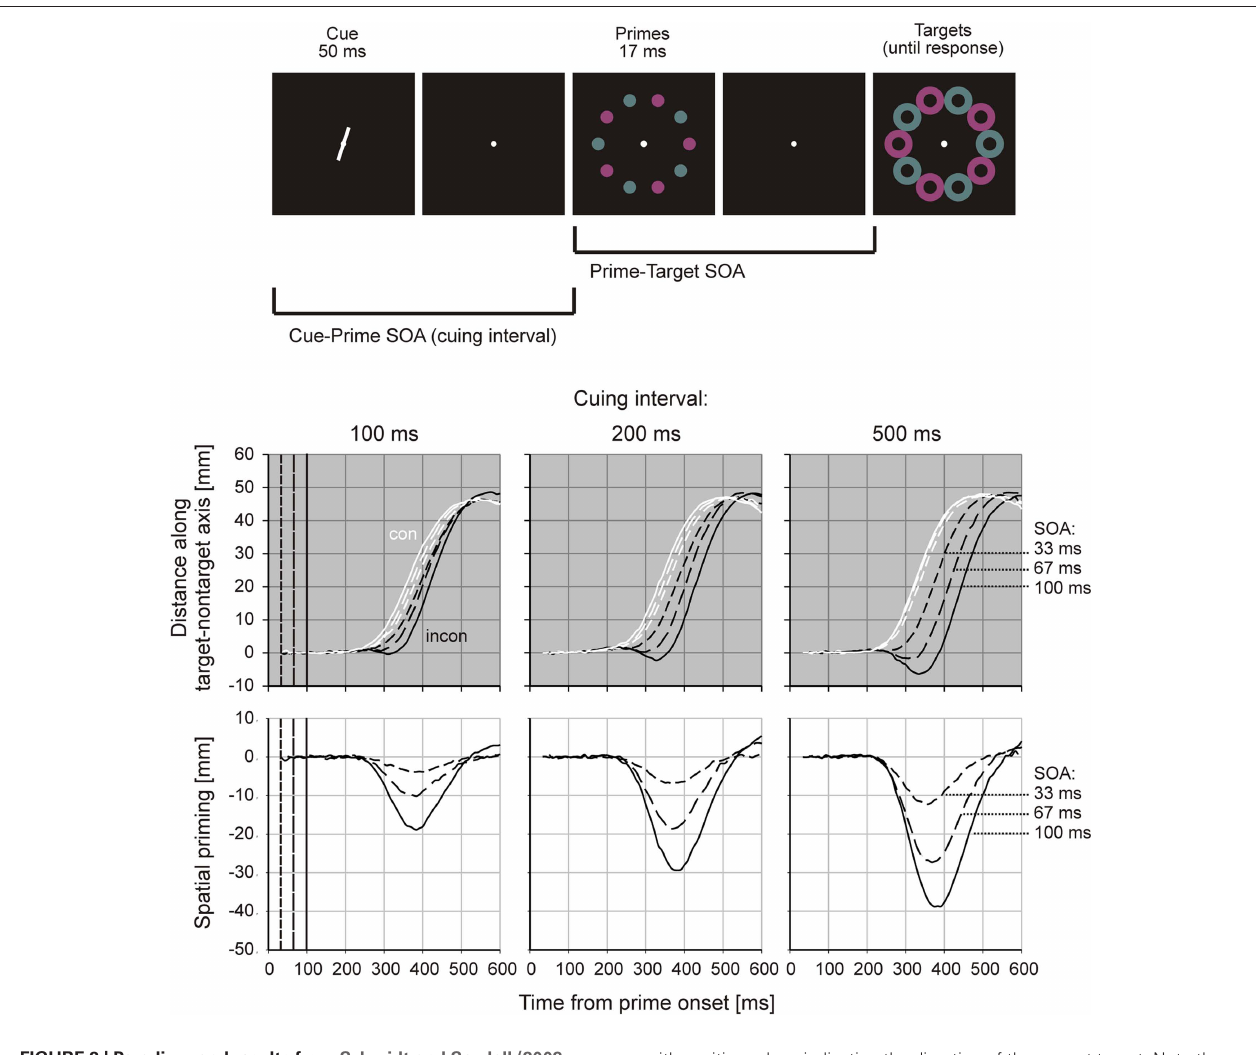
with positive values indicating the direction of the correct target. Note the detours toward the incorrect target in inconsistent trials. Lower panel: spatial priming functions for different cuing intervals. Conventions as in Figure